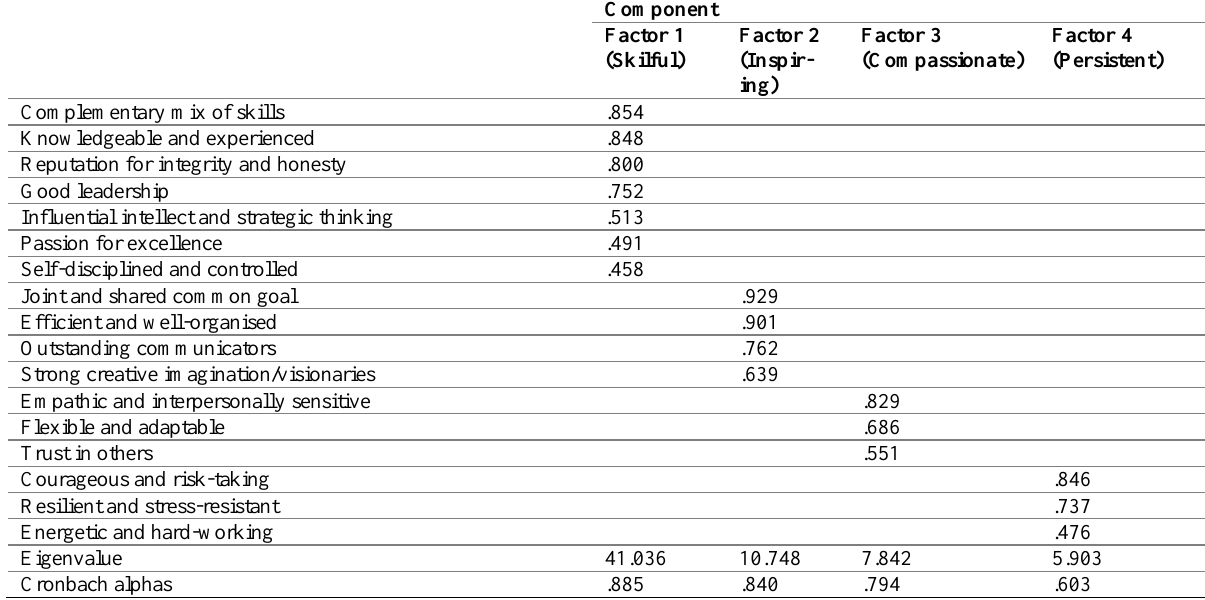
Table 5: Results of Exploratory Factor Analysis